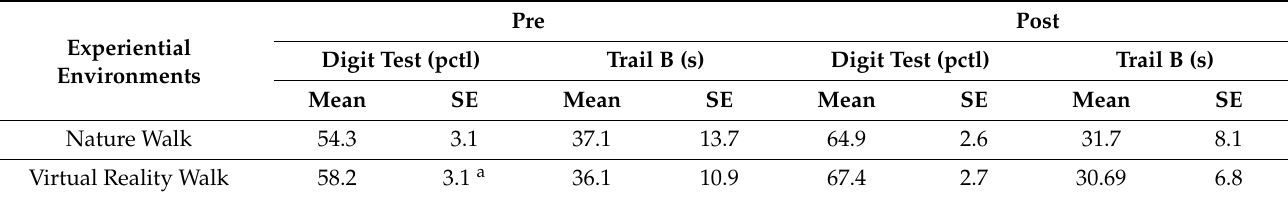
Table 1. Cognitive response to both exercise